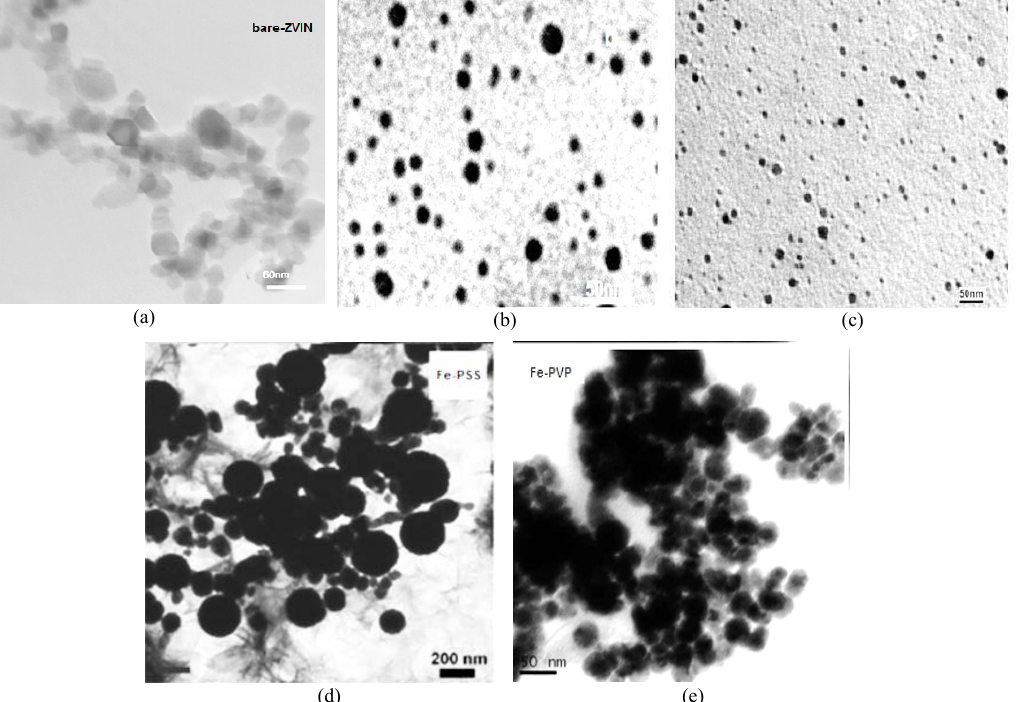
Fig.2.TEM image of (a) bare ZVINs , (b)PAM-ZVINs, (c) GG-ZVINs, (d) PSS-ZVINs, (e) PVP-ZVINs